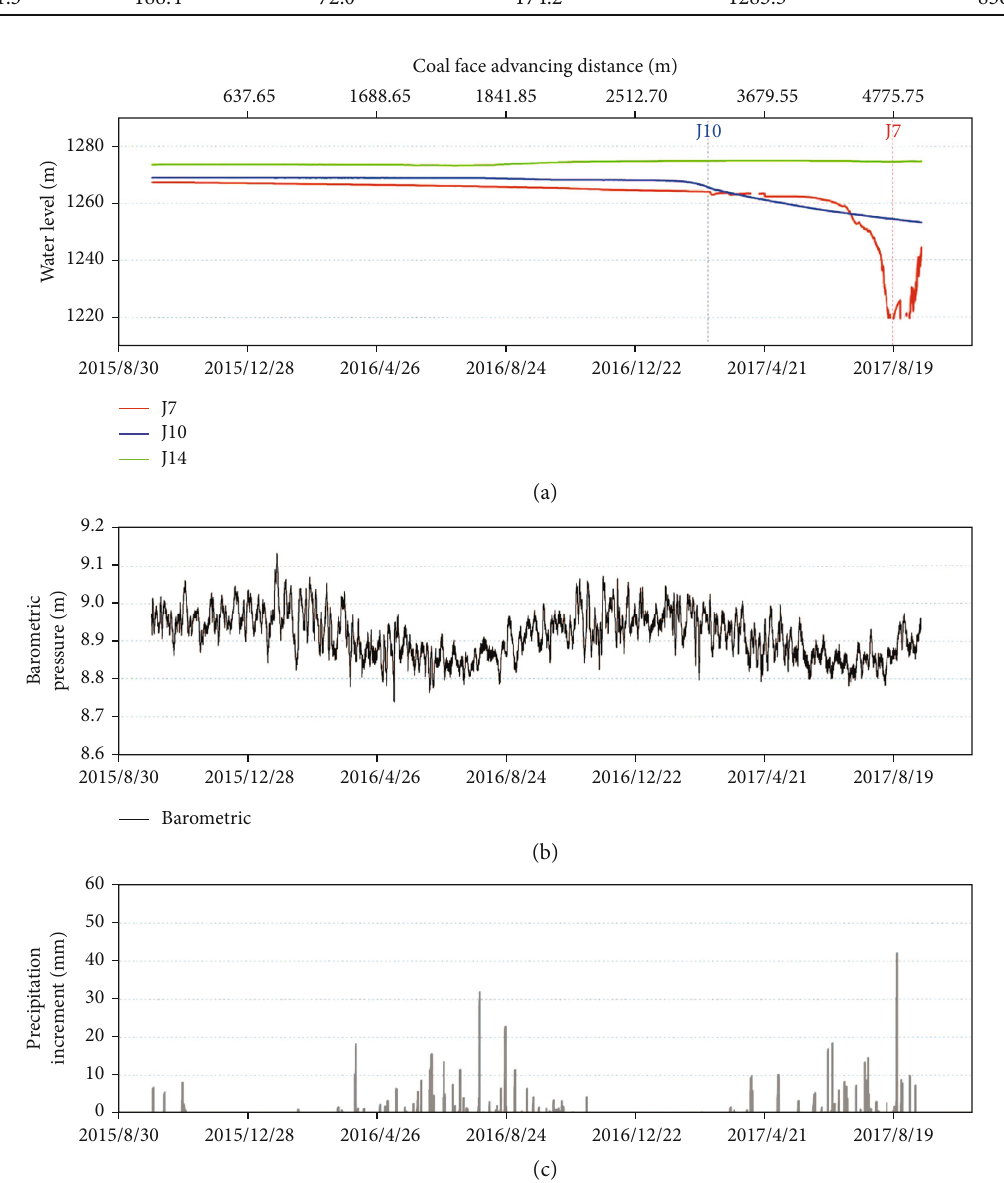
Figure 4: The observed hourly spaced record for (a) water levels, (b) barometric pressures, and (c) rainfall. The blue and red vertical dash lines show the times when the longwall excavation zone is closest to the J10 and J7 wells, respectively. The coal face advancing distance is the distance from the coal face